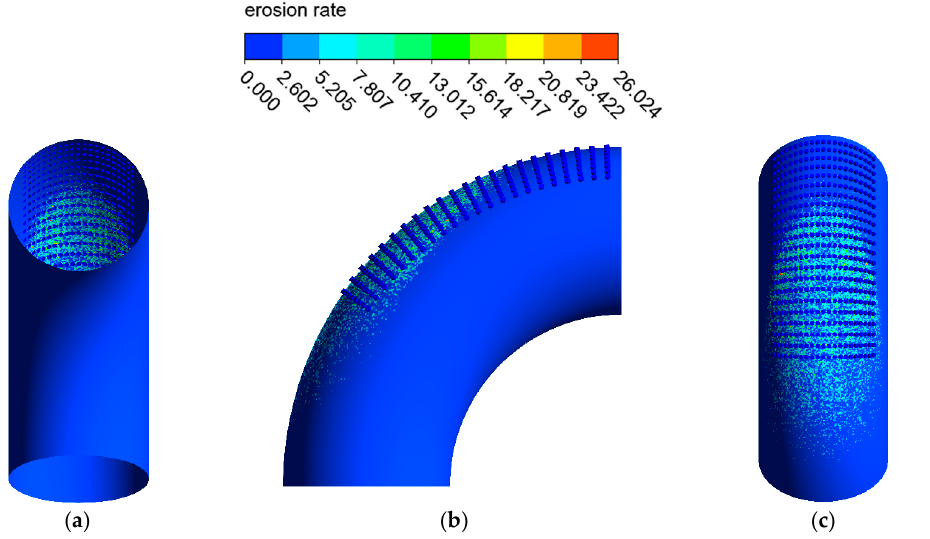
Figure 22. Distribution of the erosion rate: ( a ) view from +Y; ( b ) view from +X; ( c ) view from − Y.